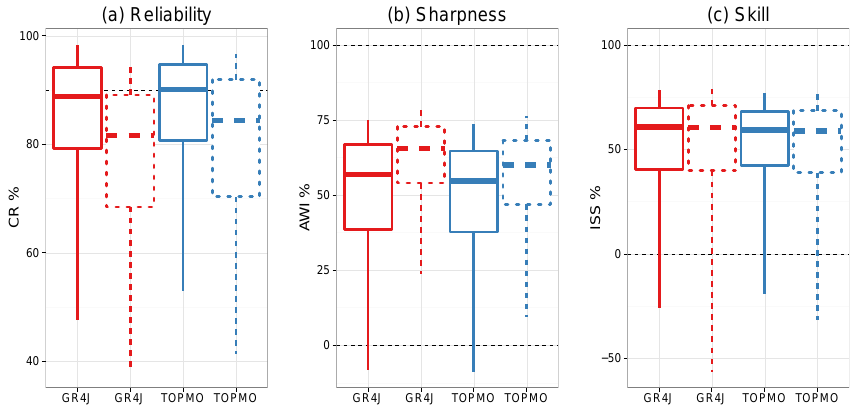
Figure 5. Distributions of the three performance criteria, obtained in two cases, (i) when the donor catchments are treated as ungauged (solid lines) and (ii) when the donor catchments are treated as gauged (dashed lines). Boxplots (5th, 25th, 50th, 75th and 95th percentiles) summarise the variety of scores over the 907 catchments of the data